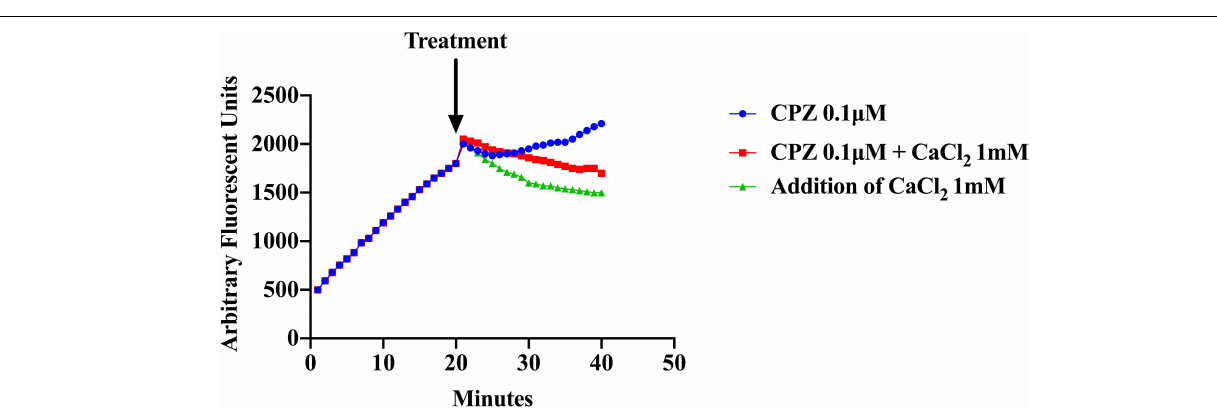
FIGURE 5 | Effect of CPZ, CPZ + CaCl 2 , and CaCl 2 on the accumulation of EtBr in S. aureus cells. Cells were incubated with EtBr and EDTA at a pH of 8 and fluorescence was measured at 585 nm for 40 min. Measurements were halted briefly after 20 min and three treatments were added to a final concentration of 0.1 µ M of CPZ, 0.1 µ M CPZ + 1 mM CaCl 2 , and 1 mM CaCl 2 and to a final volume of 100 µ l and added to a 96 well microtiter plate. Fluorescence measurements were then resumed for an additional 20 min. The addition of CPZ resulted in further EtBr accumulation (increased fluorescence) whereas the addition of CPZ + CaCl